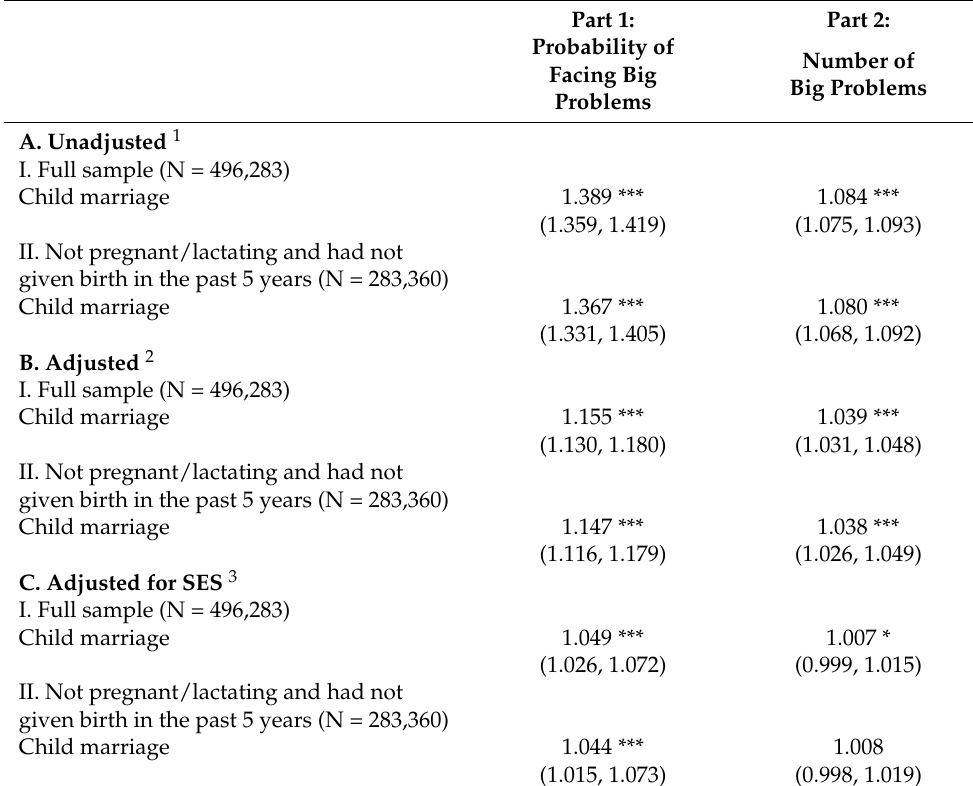
Table 8. Estimates of the hurdle